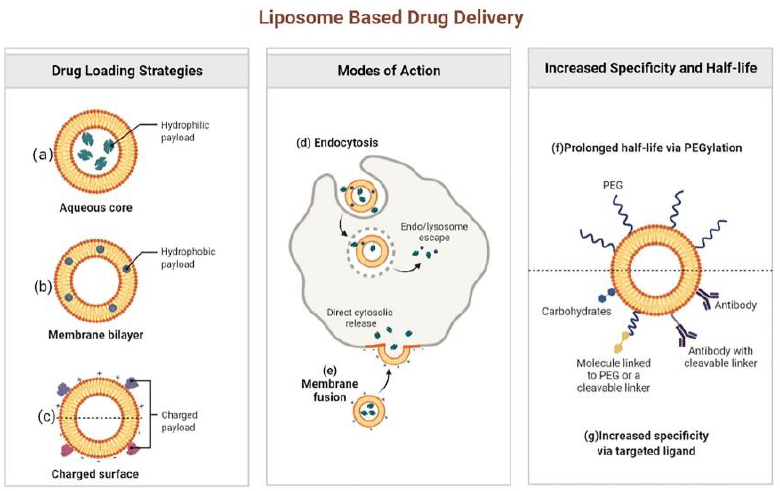
Figure 2. Liposome based drug delivery. Reprinted from ref. [28]. Copyright 2022 by BioRender.